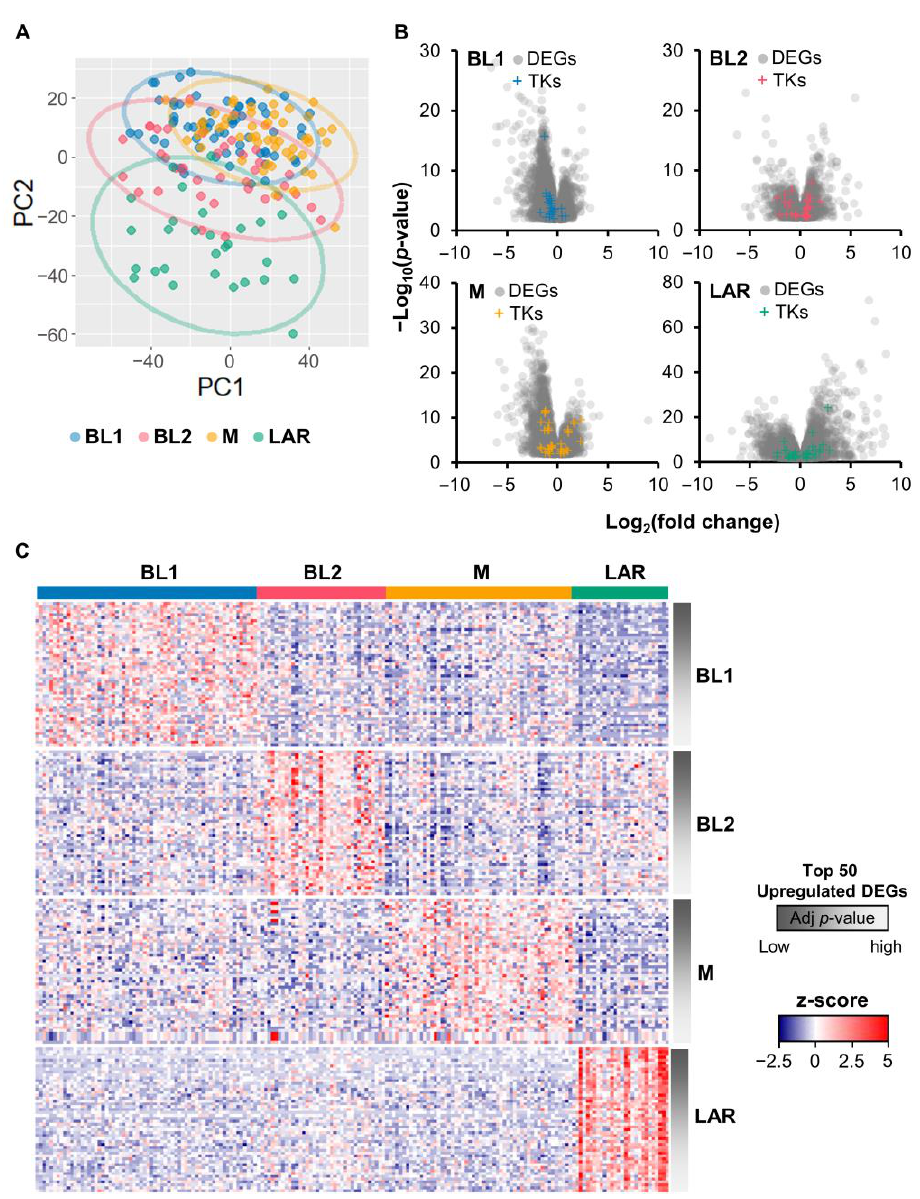
Figure 1. Differential gene expression analysis of TNBC samples from TCGA dataset. ( A ) Principal component analysis of mRNAs expression in each subtype, including BL1, BL2, M, and LAR. Each dot represented one TNBC cohort. ( B ) Volcano plot showing the gene expression differences between particular TNBC subtypes and the remaining subtypes. Gray dots represented genes with adjusted p -value < 0.05, whereas those with the plus sign (+) represented DE genes encoding protein tyrosine kinases. DEGs: differentially expressed genes. ( C ) Heatmap of the expression levels (z-score TPM) of top 50 upregulated DE genes in each subtype of TNBC. Rows were ascendingly ranked according to the adjusted p -value from the differential gene expression analysis (more to less significant), and columns represented individual cases. Red indicated overexpression, while blue indicated underexpression. ( A – C ) The BL1, BL2, M, and LAR subtypes were indicated in blue, pink, orange, and green,